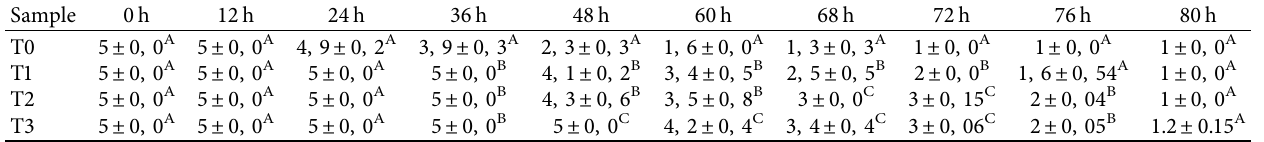
Table 2: The aroma of meatballs coated with smoke powder of various pyrolysis temperatures.